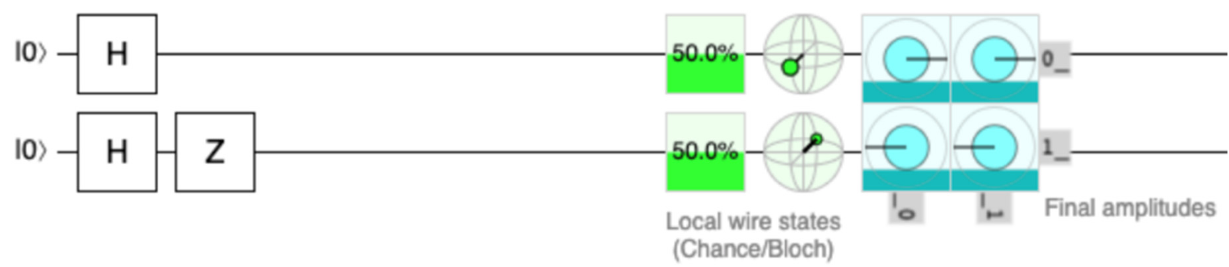
Figure 1. Two qubits in superposition and the second with a relative phase of 180° (image obtained using the https://algassert.com tool, accessed on 23 June 2021).